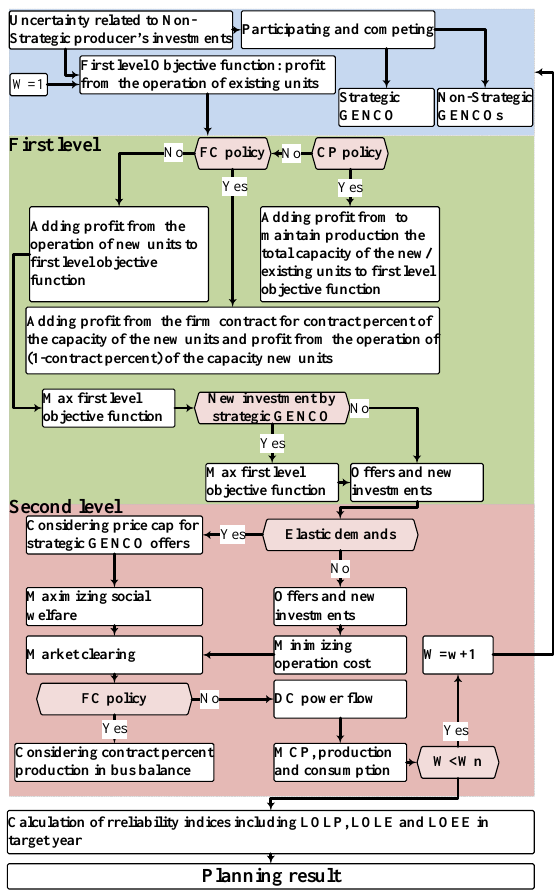
Figure 1. The algorithm for solving the proposed